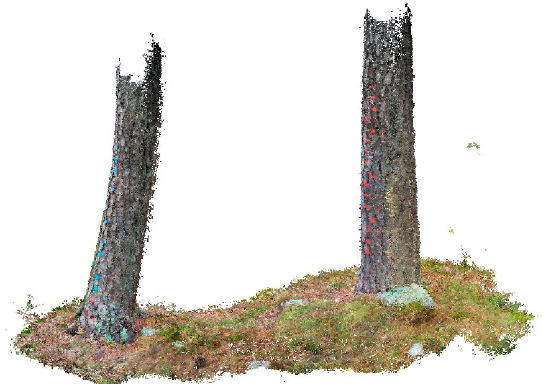
Figure 3. Two stems reconstructed in single Tango scan session.